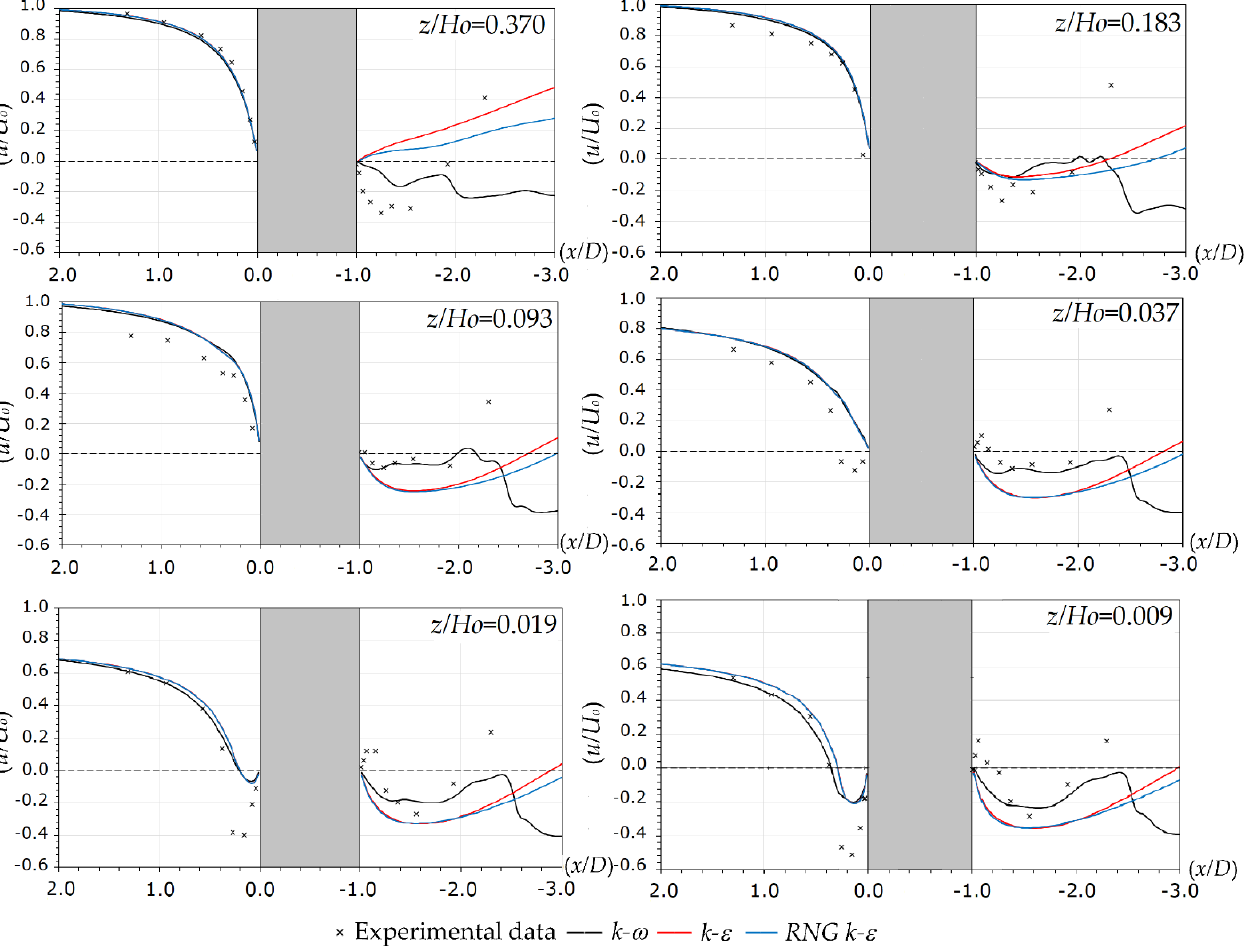
Figure 6. Validation versus [30] experimental measurements at the plane of symmetry.